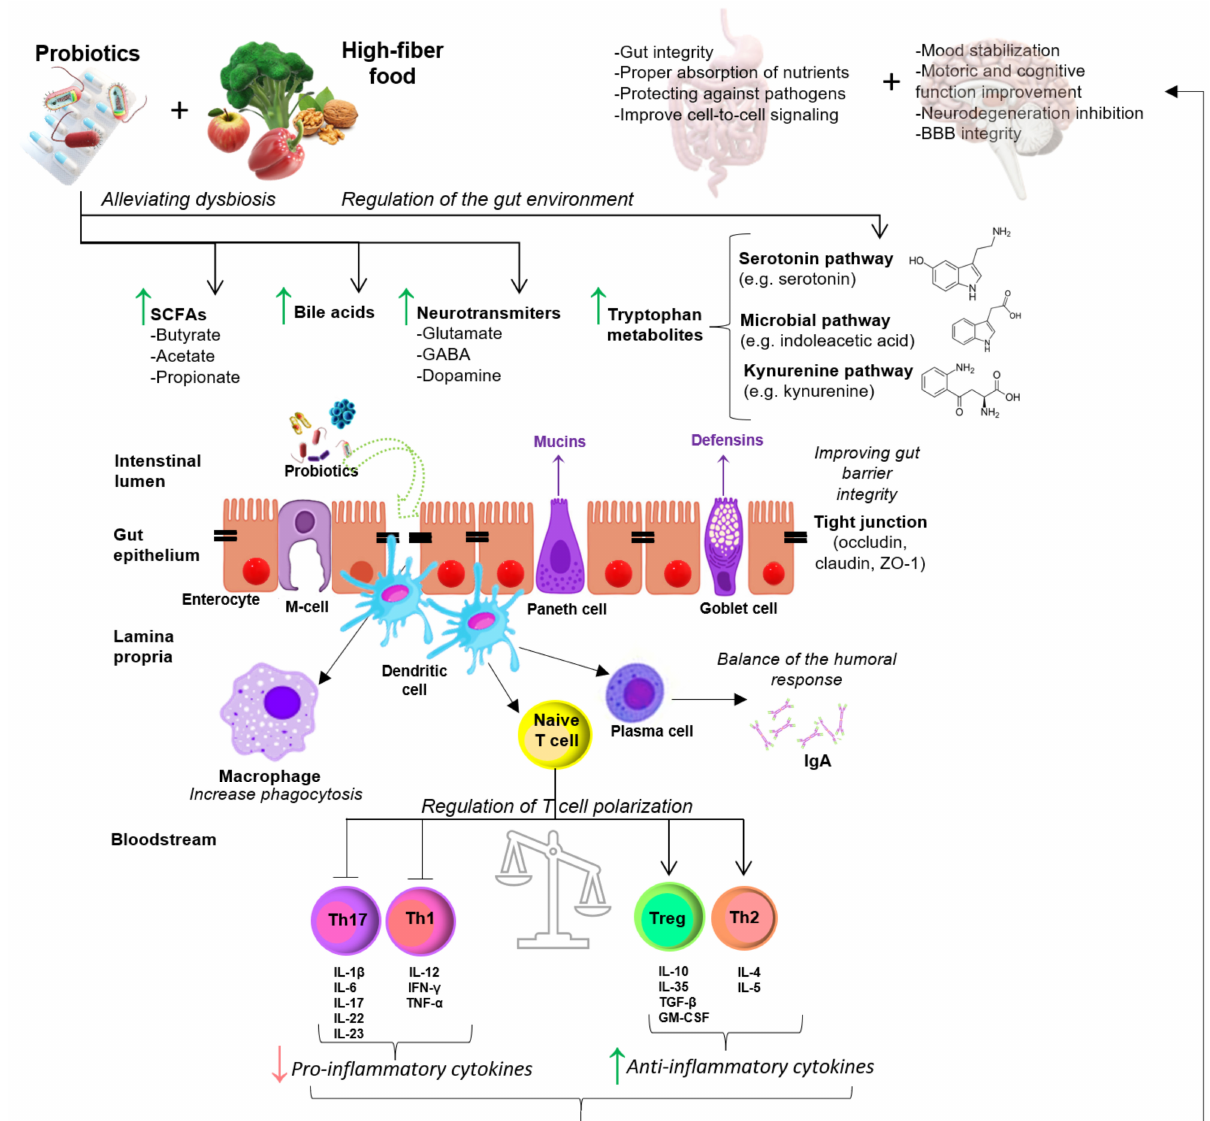
Figure 3. Potential favorable effects of probiotic supplementation on the molecular mechanisms of MS pathogenesis. Probiotics supplementation as well as high-fiber food intake, may affects the gut microflora and inhibit the increment of pathogens by inducing the host’s production of defensin and IgA by Goblet cells and plasma cells, respectively. Supplementation with appropriate amounts of probiotics causes an increase in intermediate metabolites, neurotransmitters (e.g., GABA, glutamate, and dopamine), SCFAs, and bile acids, which have a positive effect on the functioning of the intestines (e.g., proper absorption of nutrients) and the functioning of the brain (e.g., activation of serotonin and kynurenine pathways). Probiotics may be able to strengthen the gut barrier by maintaining tight junctions (e.g., occludin, zonulin, and claudin) and inducing mucin formation by Paneth cells. Probiotics via dendritic cell stimulation may regulate CD4 + T cell polarization and differentiation, leading to the production of pro-inflammatory (IL-1 β , IL-6, IL-12, IL-17, IL-22, IL-23, and TNF- α ) or anti-inflammatory (IL-4, IL-5, IL-10, IL-35, TGF- β , and GM-CSF) cytokines. Abbreviations: BBB—blood-brain barrier; GABA—gamma-aminobutyric acid; GM-CSF—Granulocyte-macrophage colony-stimulating factor; IFN- γ —interferon γ ; IgA—immunoglobulin A; SCFAs—short-chain fatty acids; Th—helper T cells; IL—interleukin; TNF- α —tumor necrosis factor α ; TGF- β —transforming growth factor β ; ZO-1—zonula